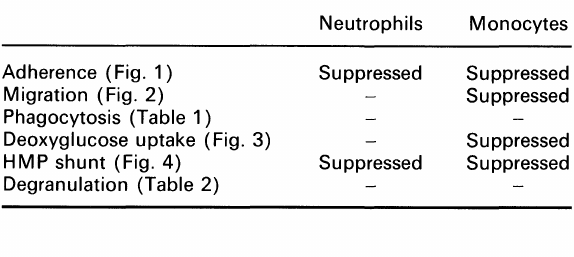
Table 3. Summary of assay results" effects of L-2 on neutrophil and monocyte activities Neutrophils Monocytes Adherence (Fig. Suppressed Suppressed Migration (Fig. 2) Suppressed Phagocytosis (Table Deoxyglucose uptake (Fig. 3) Suppressed HMP shunt (Fig. 4) Suppressed Suppressed Degranulation (Table